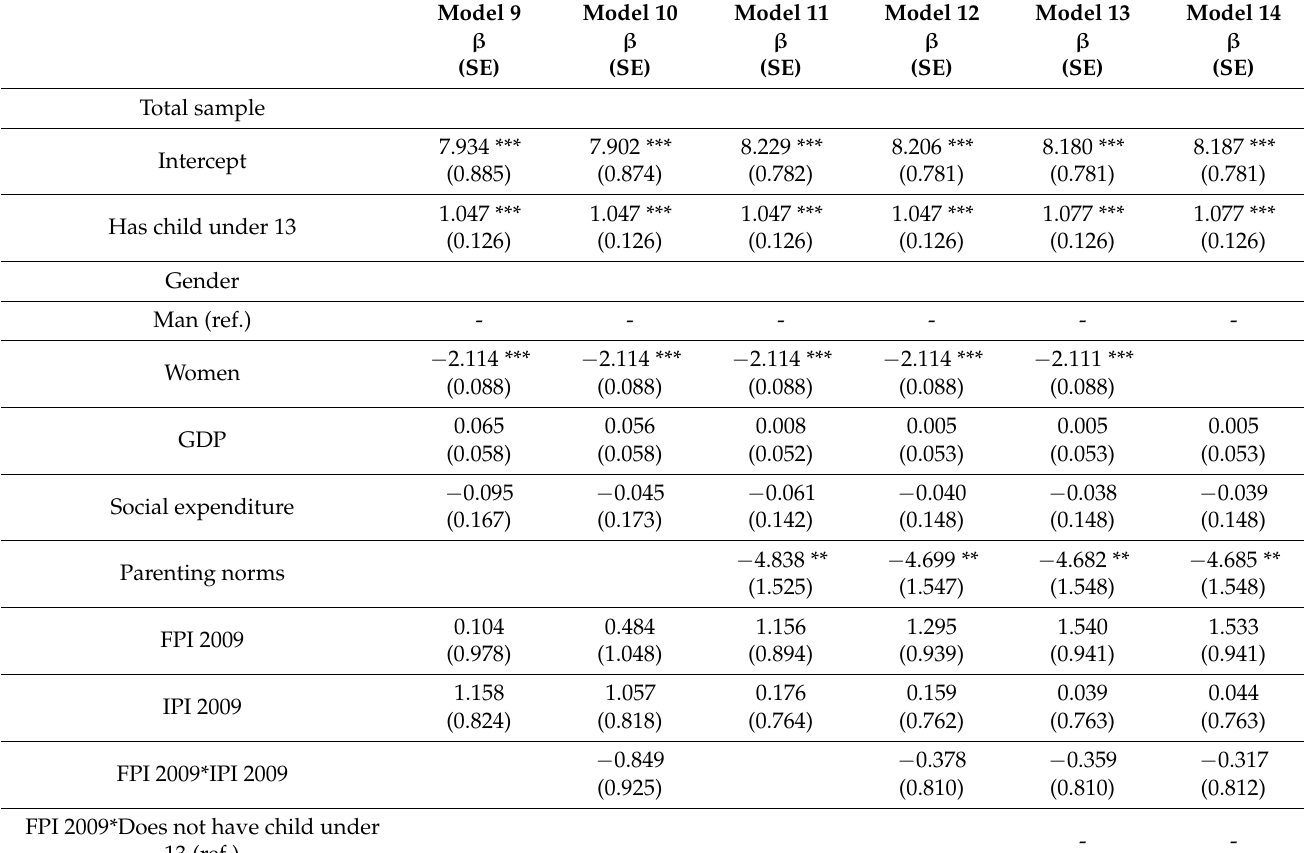
Table 4. Multilevel regression of mental health on family policy environment and controls—main effects at the macrolevel and cross-level interaction effects; total sample, women, and men